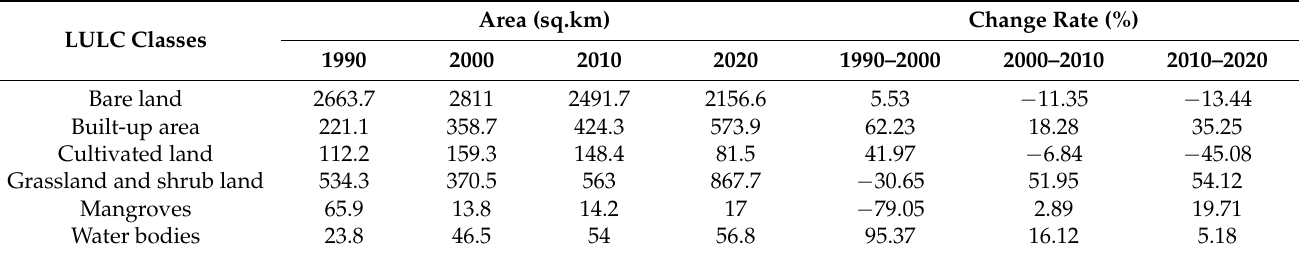
Table 3. Areal changes in each land use land cover type in